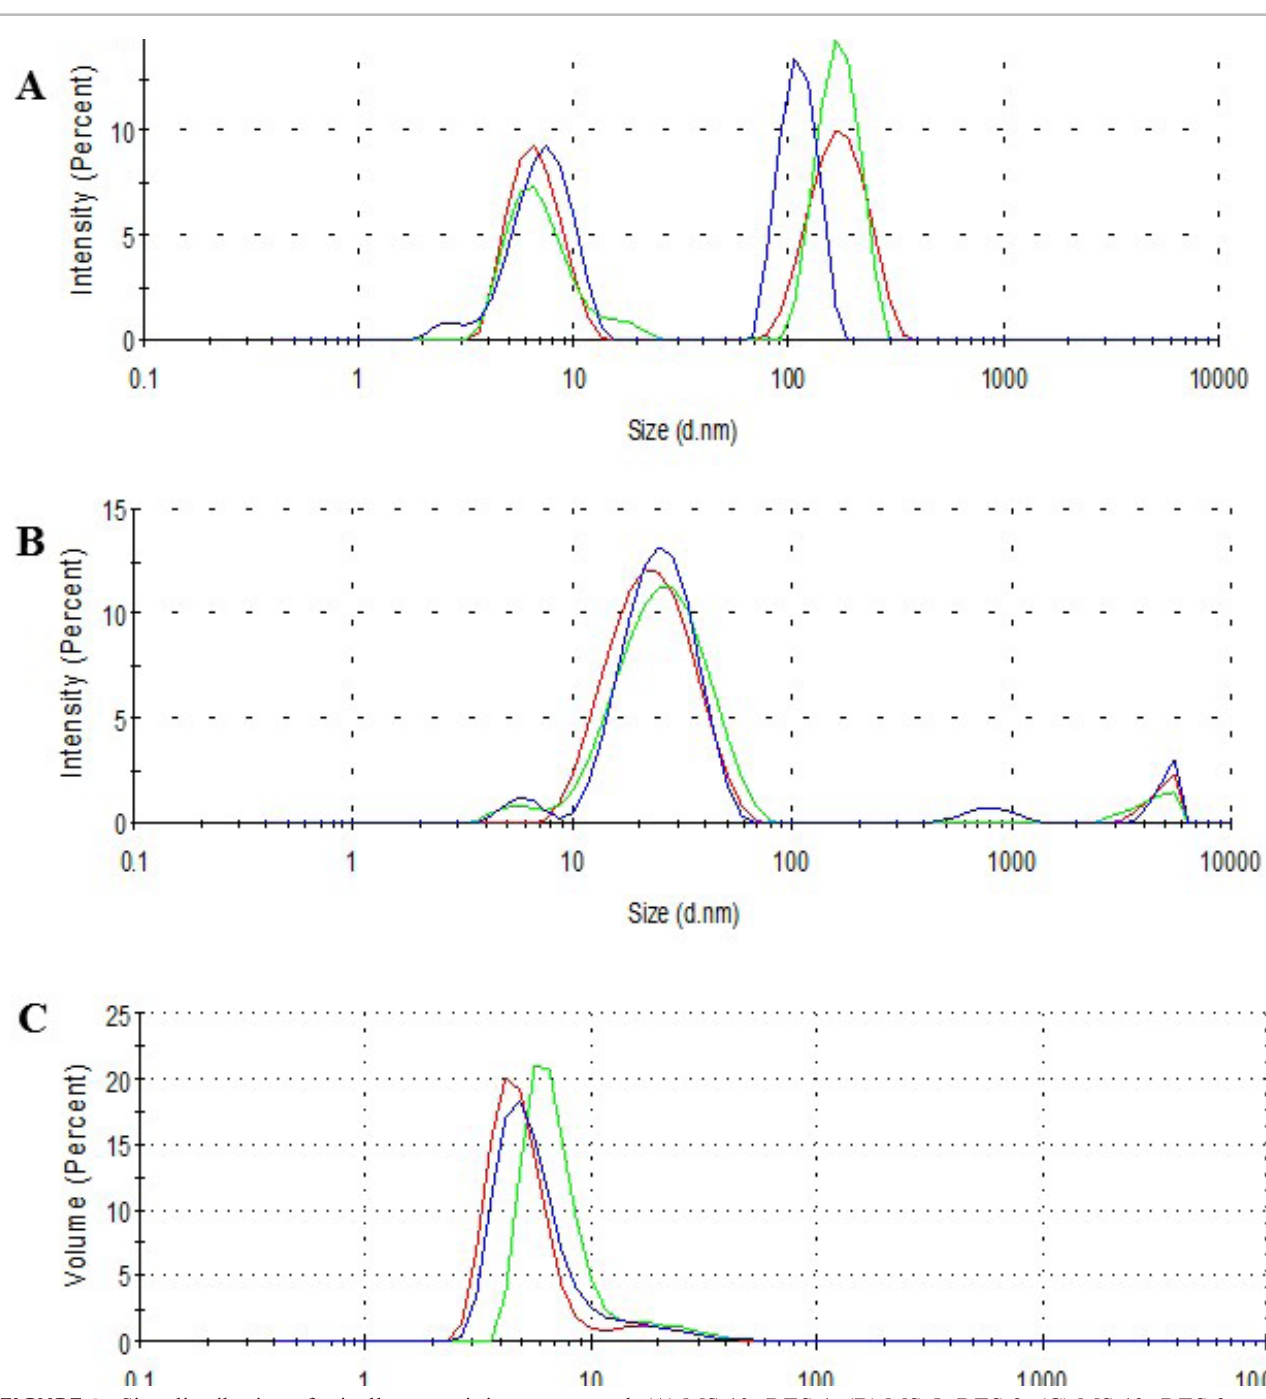
FIGURE 1 - Size distribution of micelles containing resveratrol. (A) MS-10+RES-1; (B) MS-5+RES-2; (C)